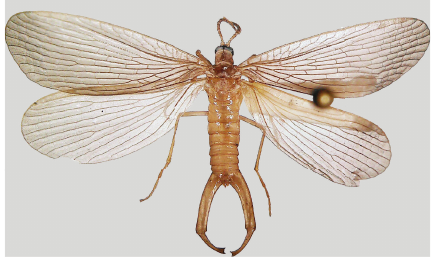
Figure 1: Merope tuber , male.